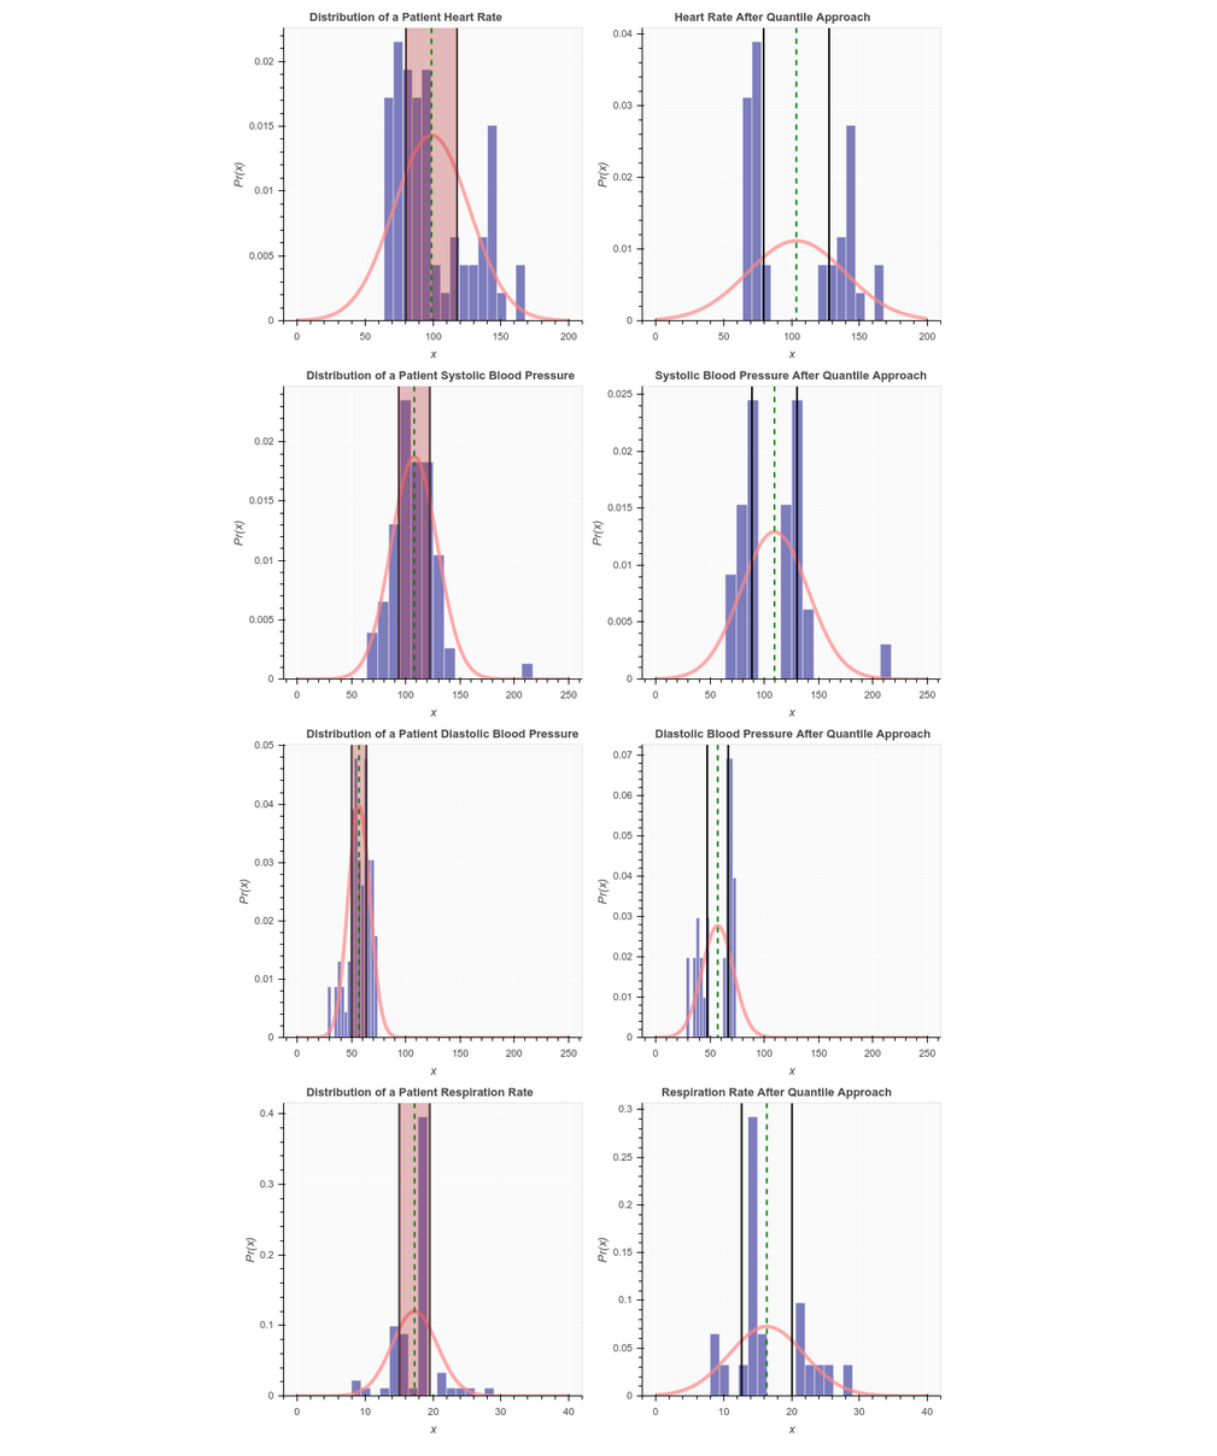
Figure 4. Distribution of a sample patient observation before and after applying the quantiles